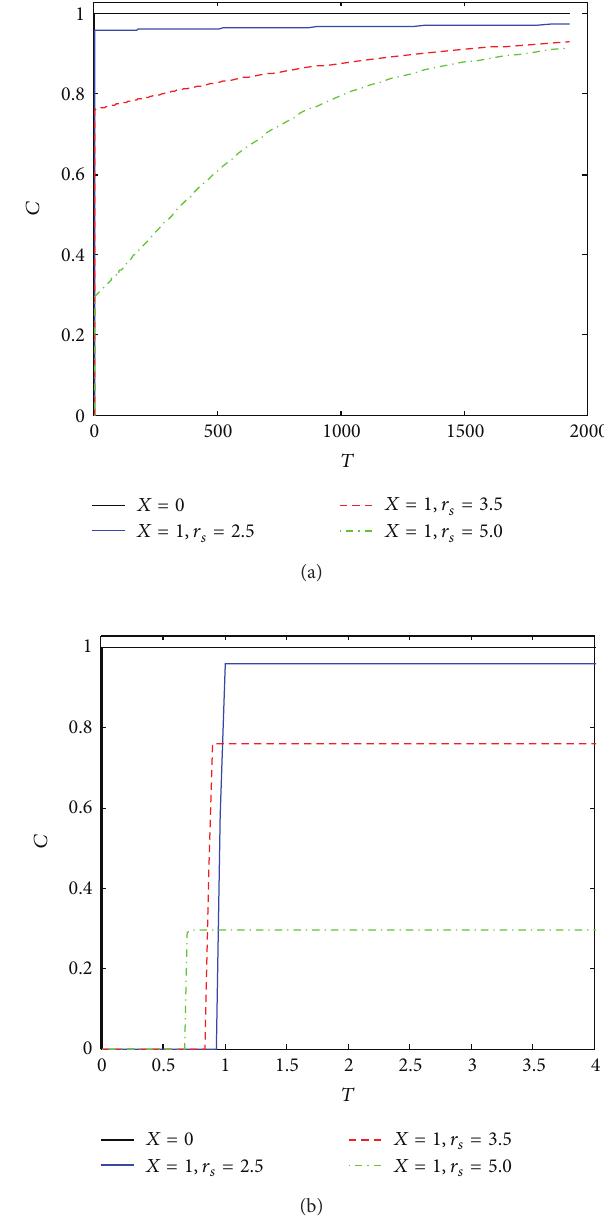
Figure 3: Suspended particle concentration at the core inlet and outlet: (a) full time scale history; (b) zoom-in at the early stage.